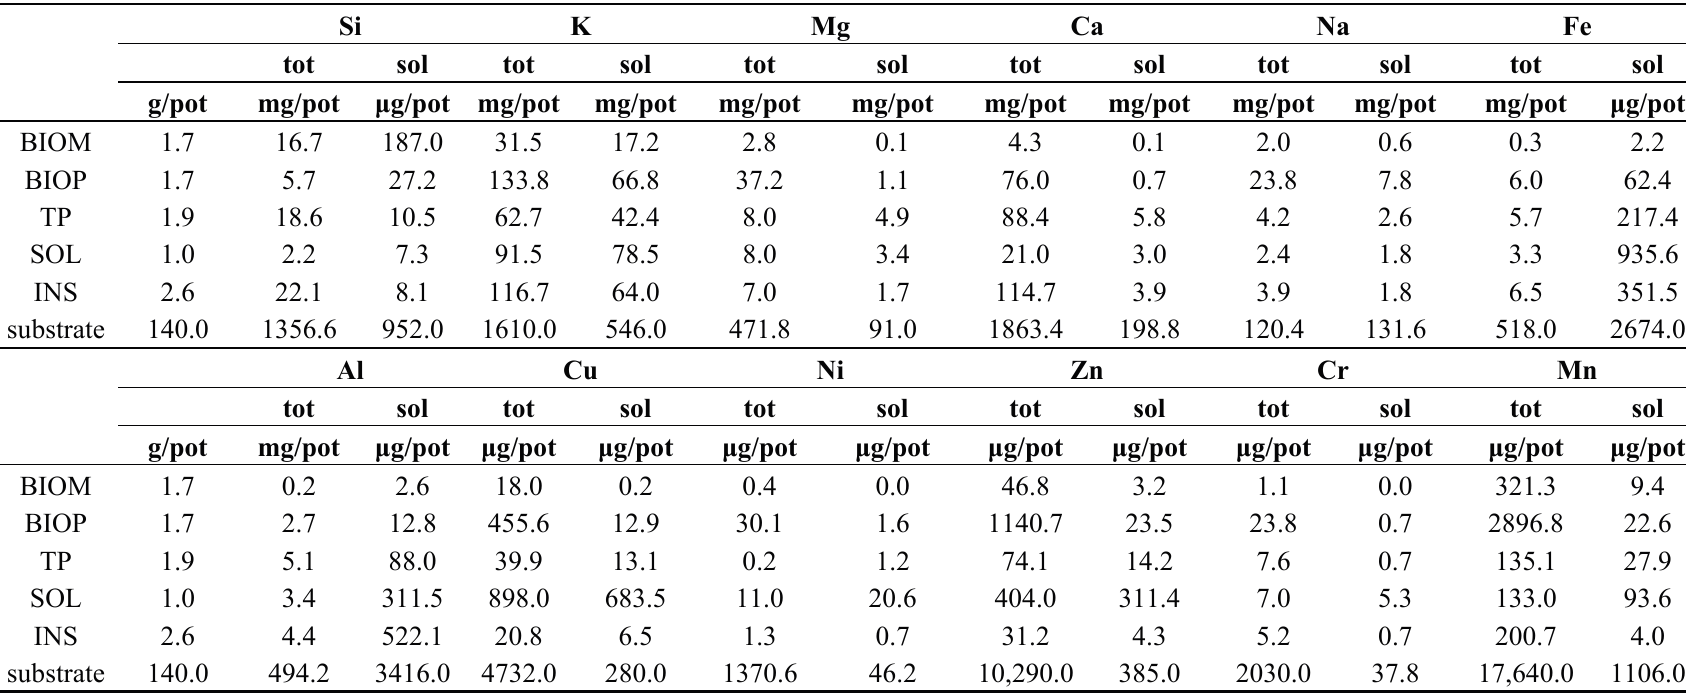
Table 4. Amount of total and soluble mineral elements added per